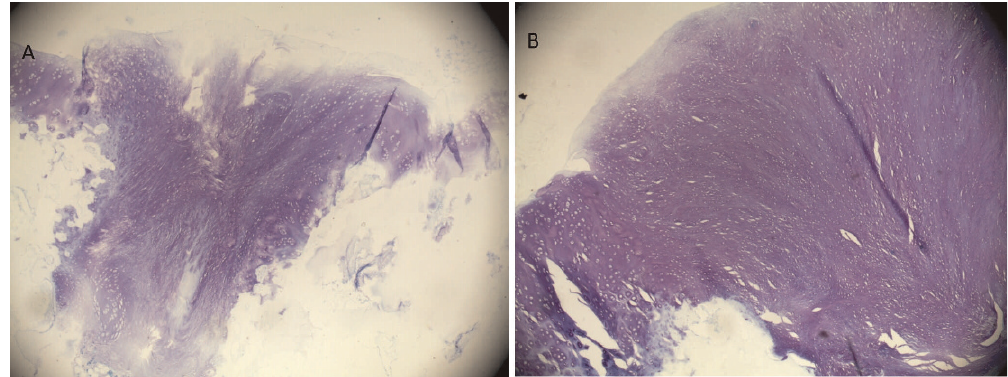
Figure 4 - Histological view of rabbit 21 microscopic samples, stained with toluidine blue (4 6 zoom). A) Right side; B) Left side. Note the deep repair tissue, with a lush matrix and numerous chondrocytes on both sides, but better organized on the left side (B) (source: personal